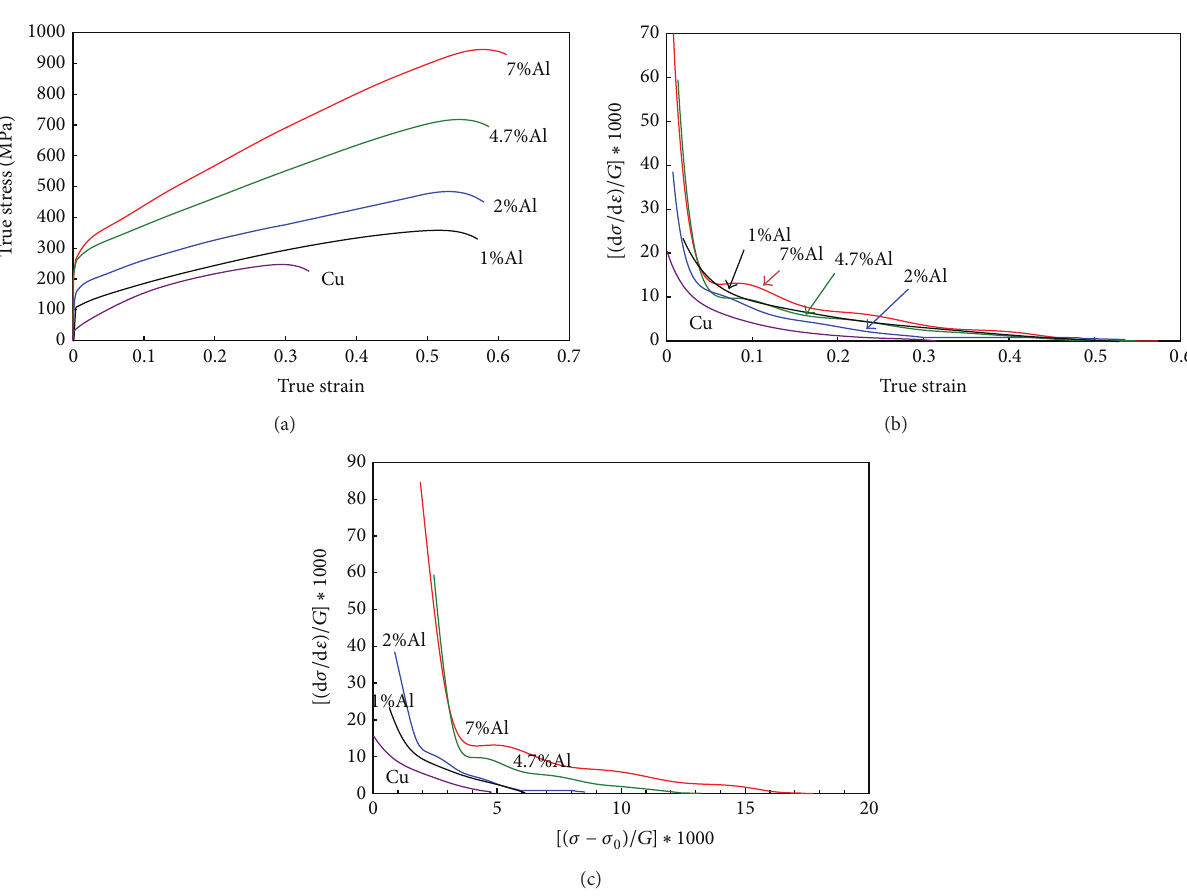
Figure 6: True stress-true strain response for all materials with an average grain size of 70 𝜇 m, tested in tension. Normalized strain hardening rate versus true strain in (b) and versus normalized stress parameter in (c) for all materials displayed in part (a).